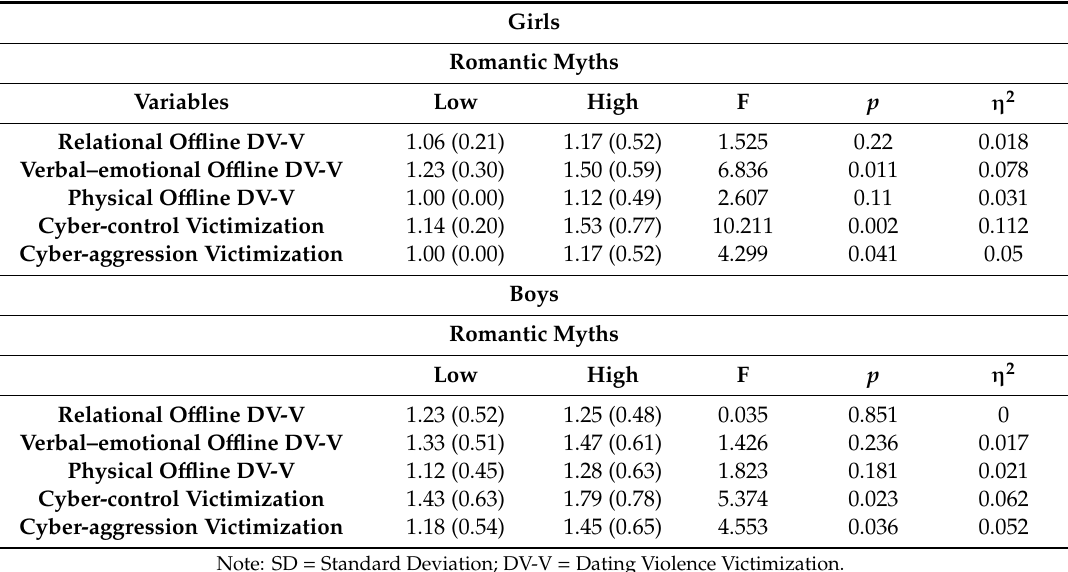
Table 2. Means (SD) in O ffl ine Dating Violence Victimization and Cyber Dating Violence Victimization in Adolescent Girls and Boys with Low and High Scores for Beliefs in Romantic